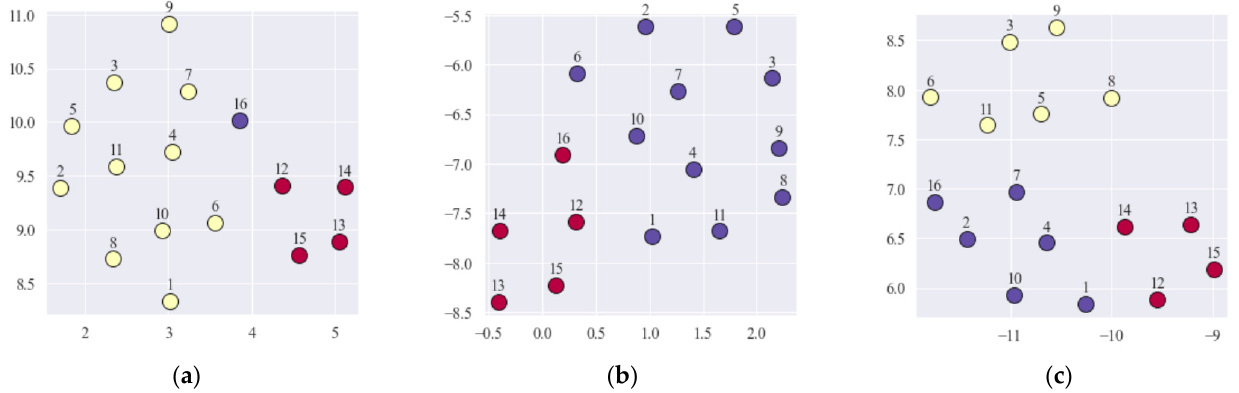
Figure 3. Results of visualization of clusters in the group of 16 CPs, represented by multisets: ( a )—purely risky assessment strategy (three clusters, the value of the cluster silhouette index is 0.426); ( b )—neutral assessment strategy (two clusters, the value of the cluster silhouette index is 0.230); ( c )—purely conservative assessment strategy (three clusters, the value of the cluster silhouette index is 0.218).